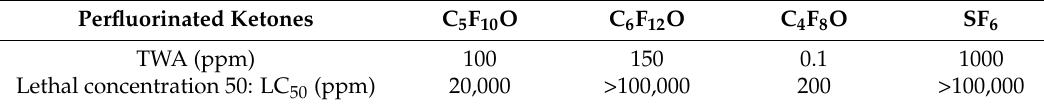
Table 10. Toxicological data of some perfluorinated ketones [44].